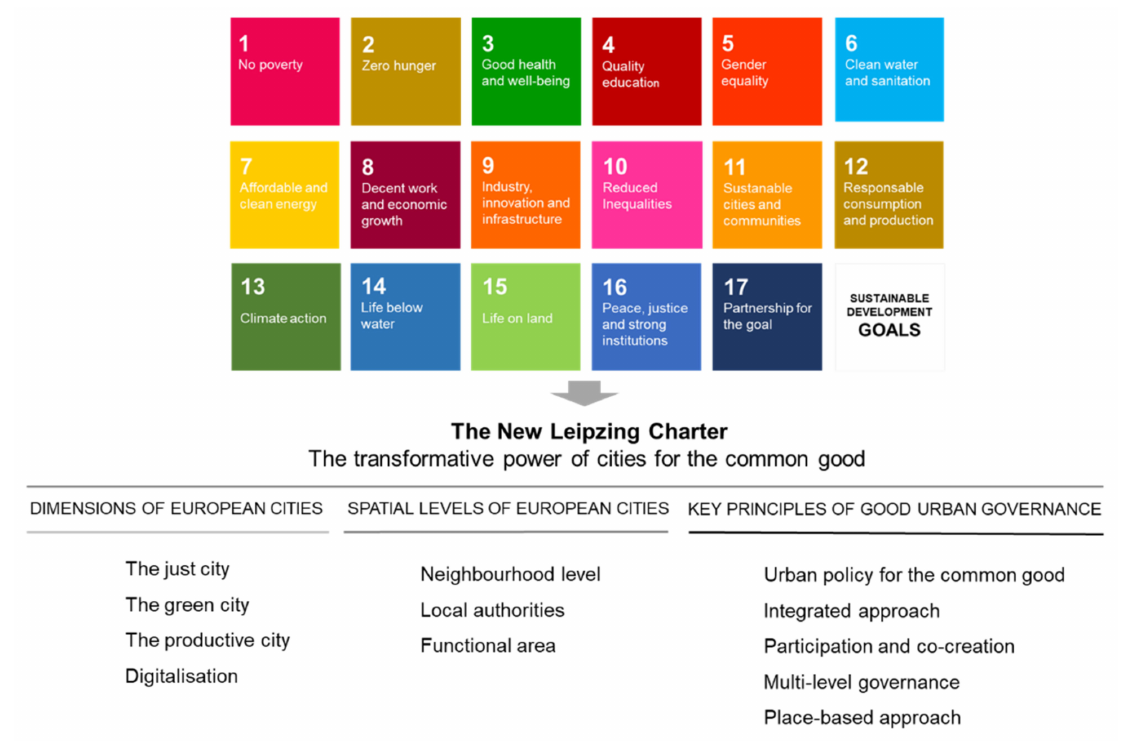
Figure 1. The links between the New Leipzig Charter and the Sustainable Development